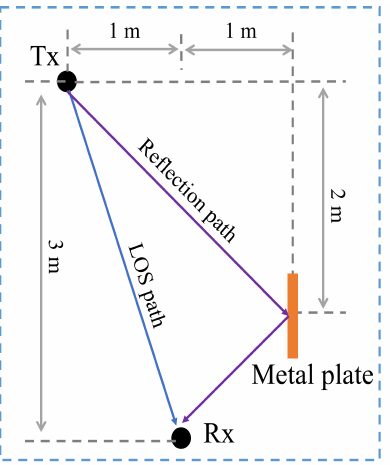
Figure 13. Placement of the Tx, Rx and metal